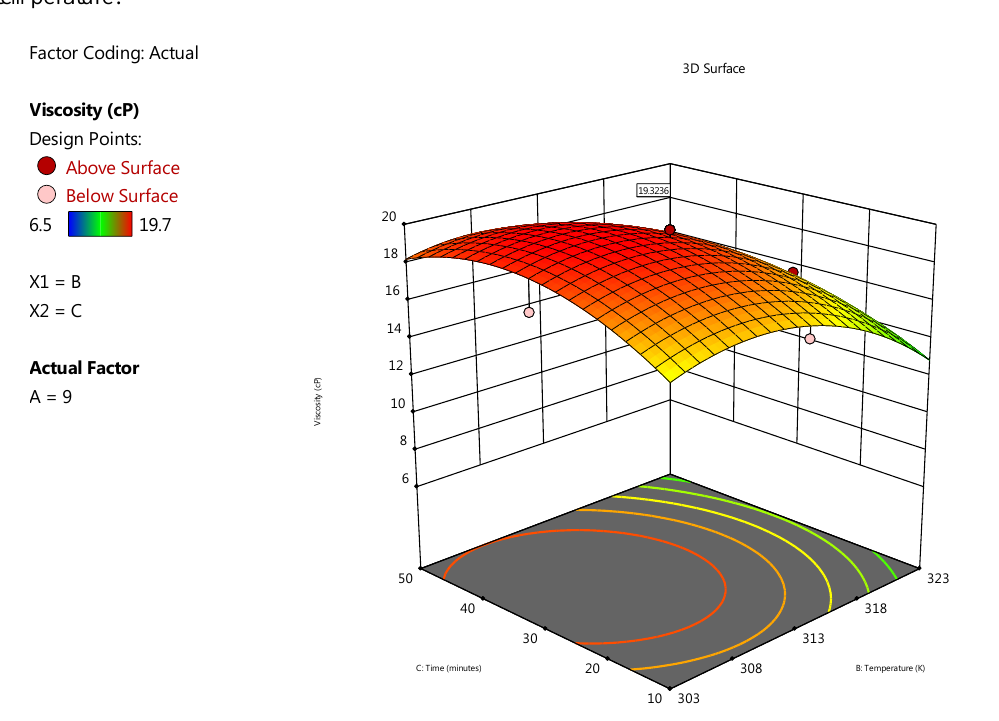
Figure 6. Effect of temperature and time on viscosity of OBMB